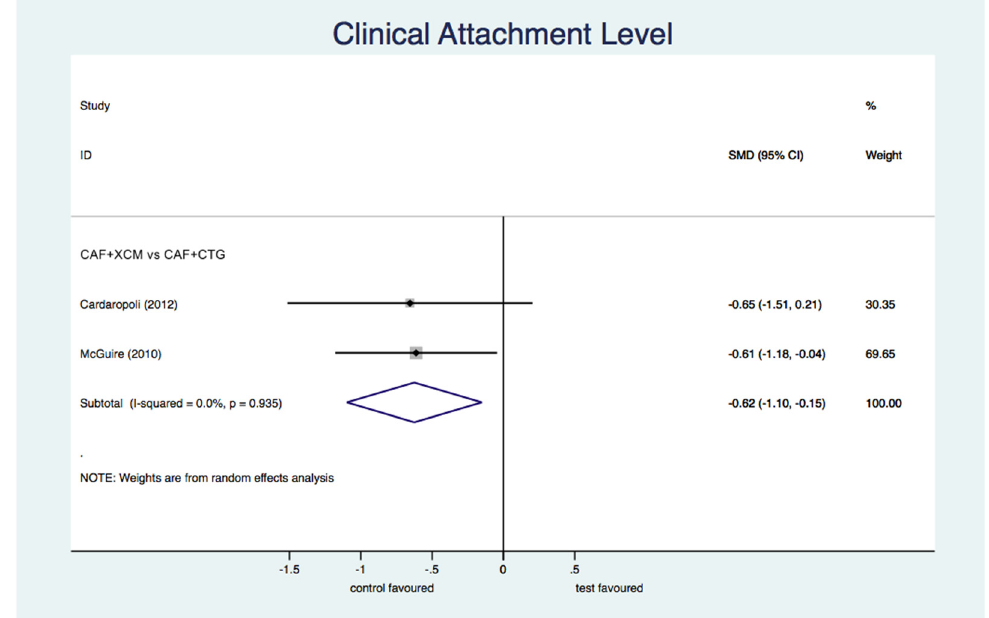
Figure 7. Forest plot relating to the clinical attachment level.